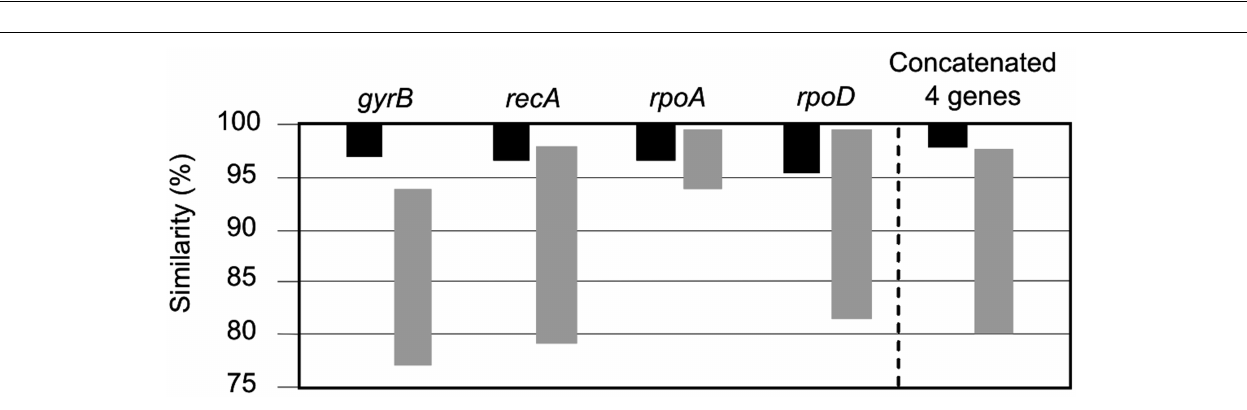
FIGURE 4 | Relationship between five-gene MLSA evolutionary distance and DDH data for Salinivibrio . Each solid diamond represents Salinivibrio strains plotted against the DDH value of the strains ( x -axis) versus the MLSA evolutionary distance ( y -axis).